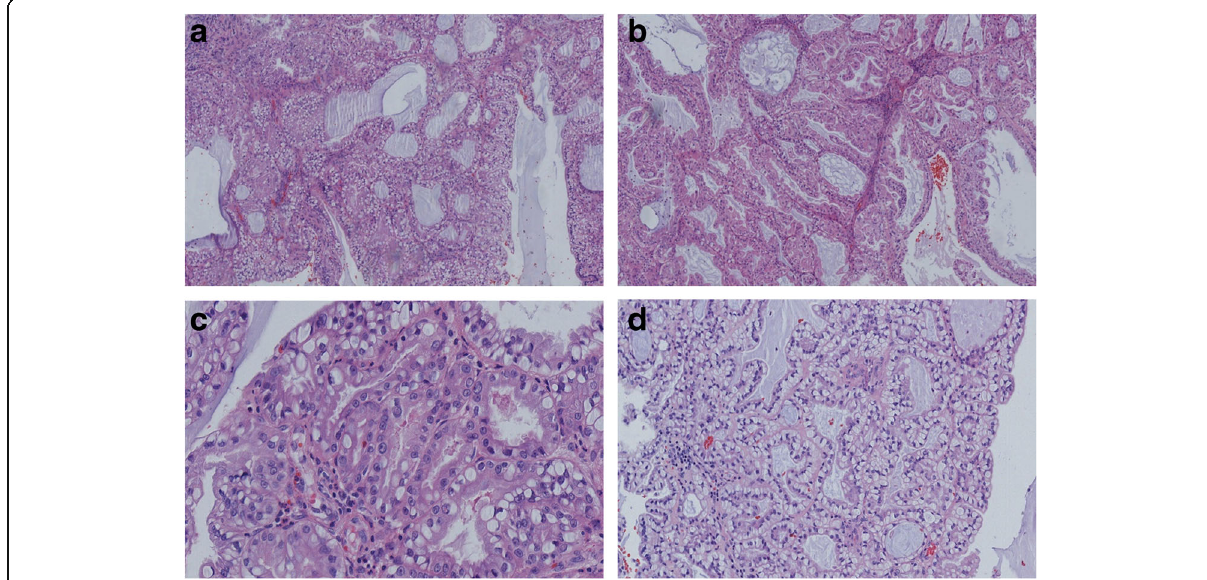
Fig. 2 a The tumor consists of nests and follicles of polyhedral cells with abundant optically clear cytoplasm. Nuclear pleomorphism and mitotic activity are minimal. The follicles are filled with basophilic secretions(magnification × 100). b There is also micropapillary configuration that